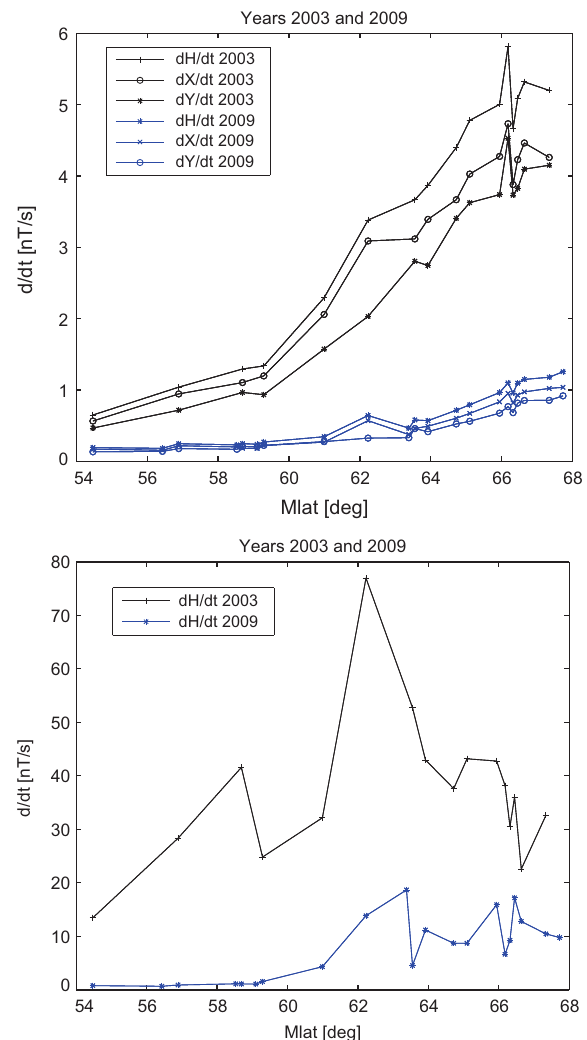
Fig. 4. Average daily maximum of the time derivative of the 10-s geomagnetic field and maximum of the time derivative of the horizontal geomagnetic field as a function of geomagnetic latitude in 2003 and 2009. Year 2003 represents a very active time and 2009 is geomagnetically